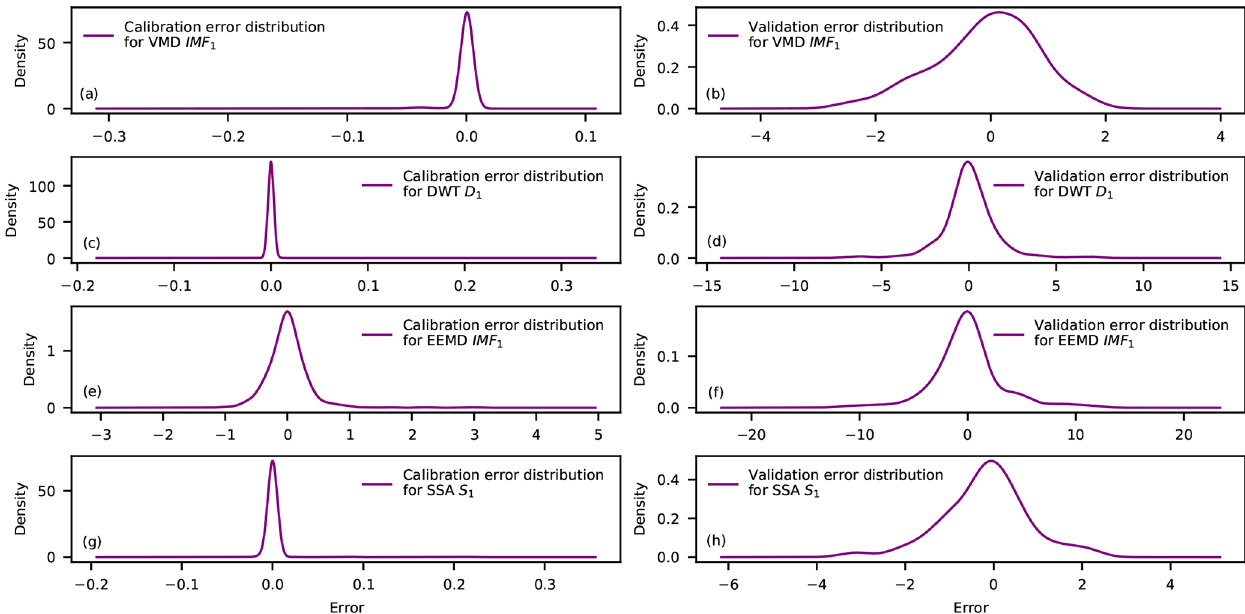
Figure 4. Density estimates with Gaussian-type kernels for the calibration and validation error distributions of the monthly runoff decompo- sitions of the Huaxian station. The real decompositions are the joint decompositions of the entire monthly runoff for the period from January 1953 to December 2018.